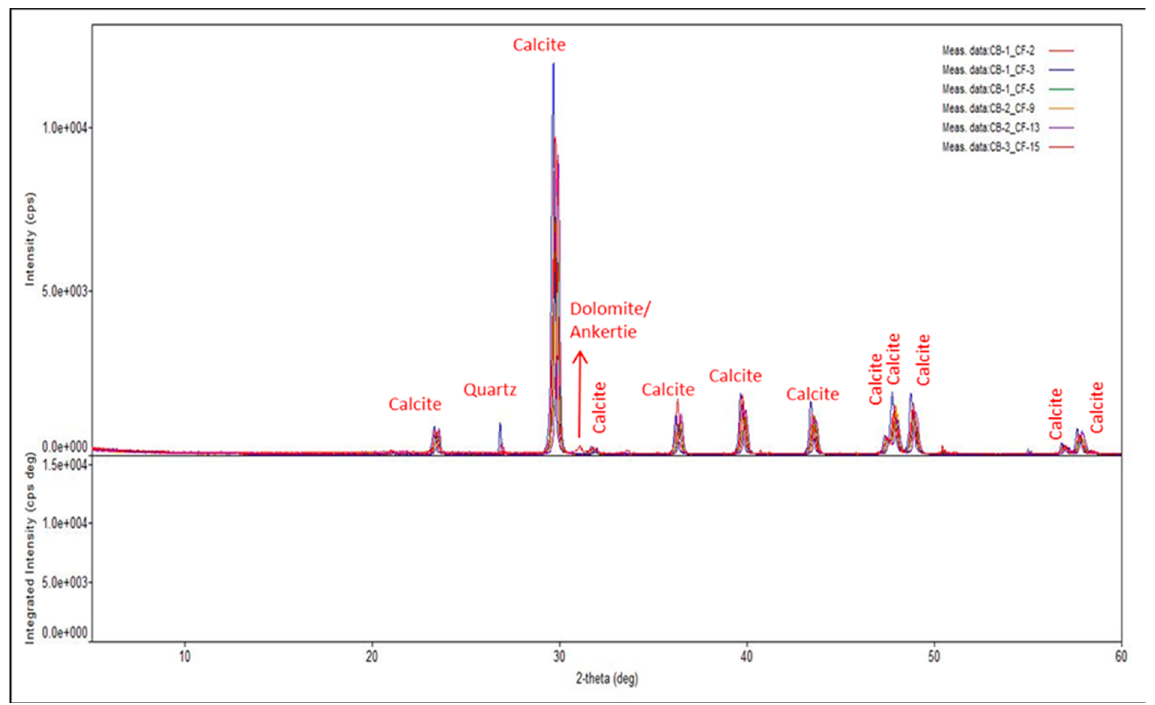
Figure 1. Results of XRD analysis of six different rock samples which shows that the rock is composed of dominantly calcite with traces of dolomite and quartz.